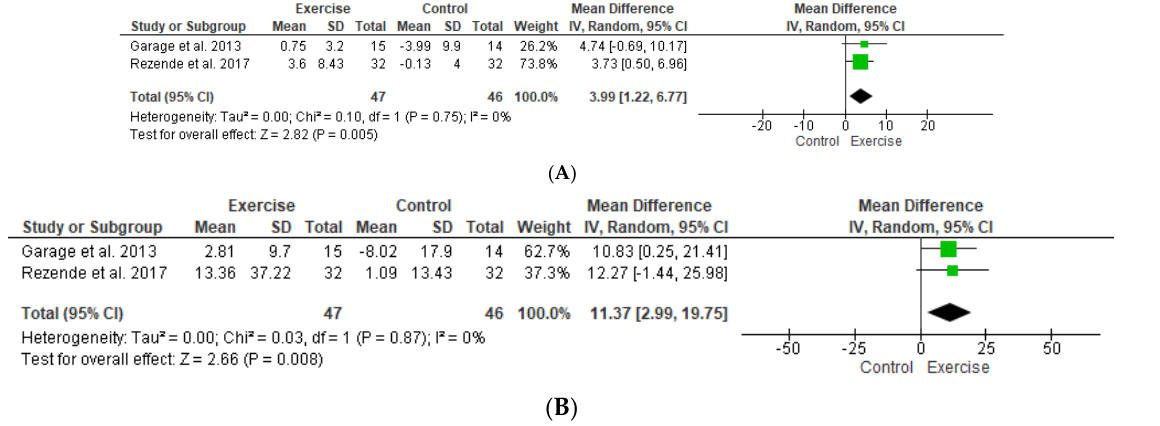
Figure 2. Forest plot of meta-analysis results presented as pooled standard mean differences with 95% CIs for changes in ( A ) SD1 and ( B ) SD2 for exercise and control groups. The exercise effects are plotted with black diamonds. IV, inverse variance; SD1, standard deviation of instantaneous beat-to-beat variability; SD2, standard deviation of the long-term variability [22,23].